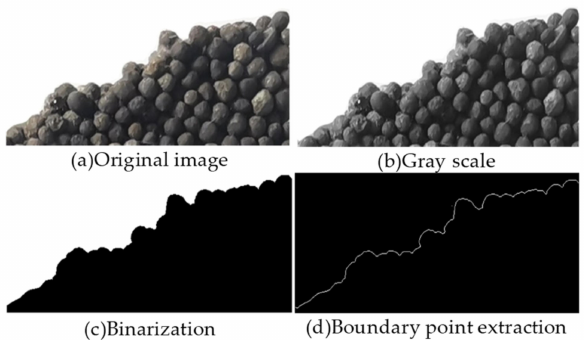
Figure 7. Measurement of repose angle of the granular fungal